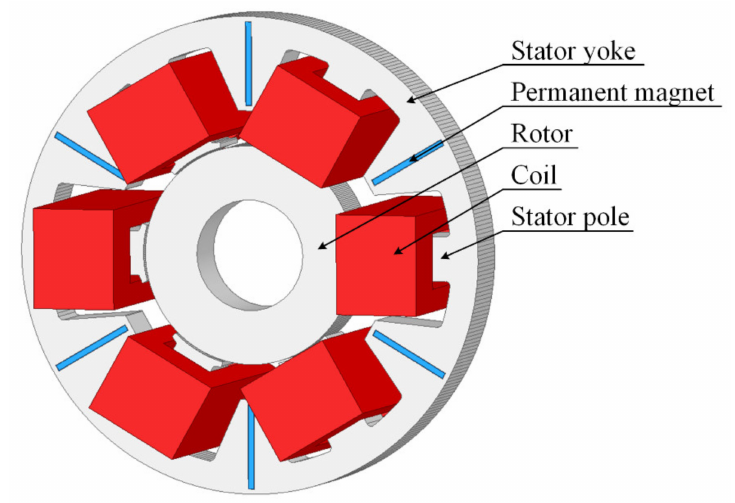
Figure 1. The geometry of the HMB magnetic circuit.